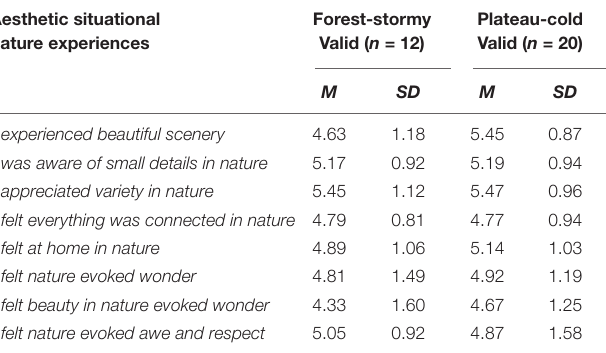
TABLE 1 | Means for situational aesthetic nature